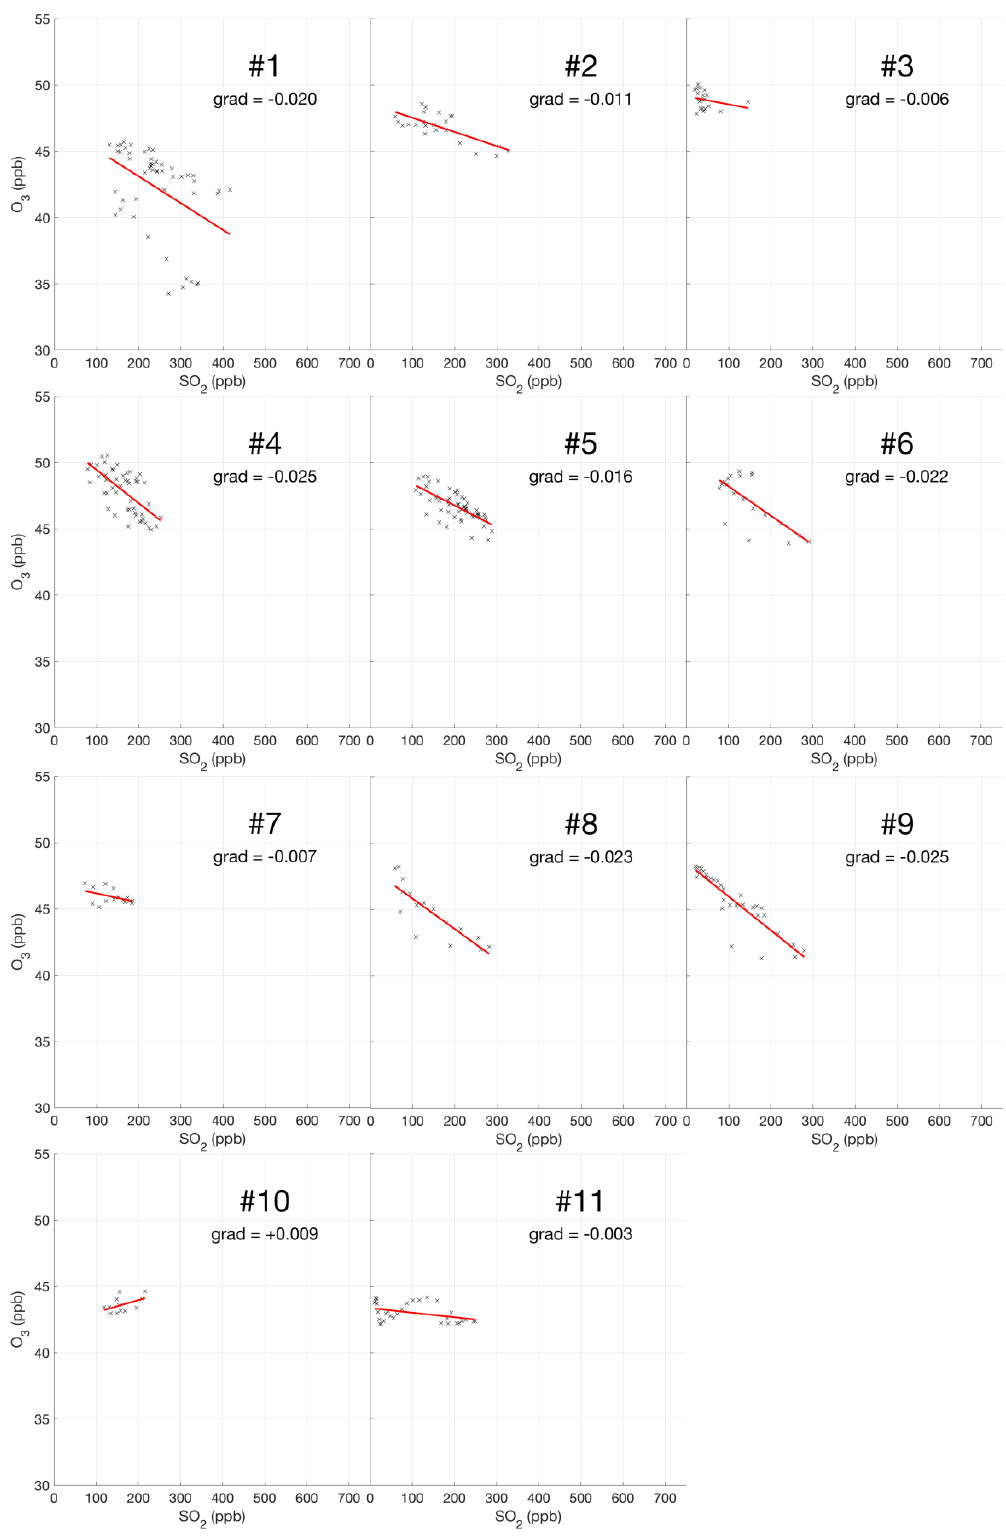
Figure 4. Measurements of SO 2 and O 3 mixing ratios for the 11 major plume encounters on 31 July 2012.